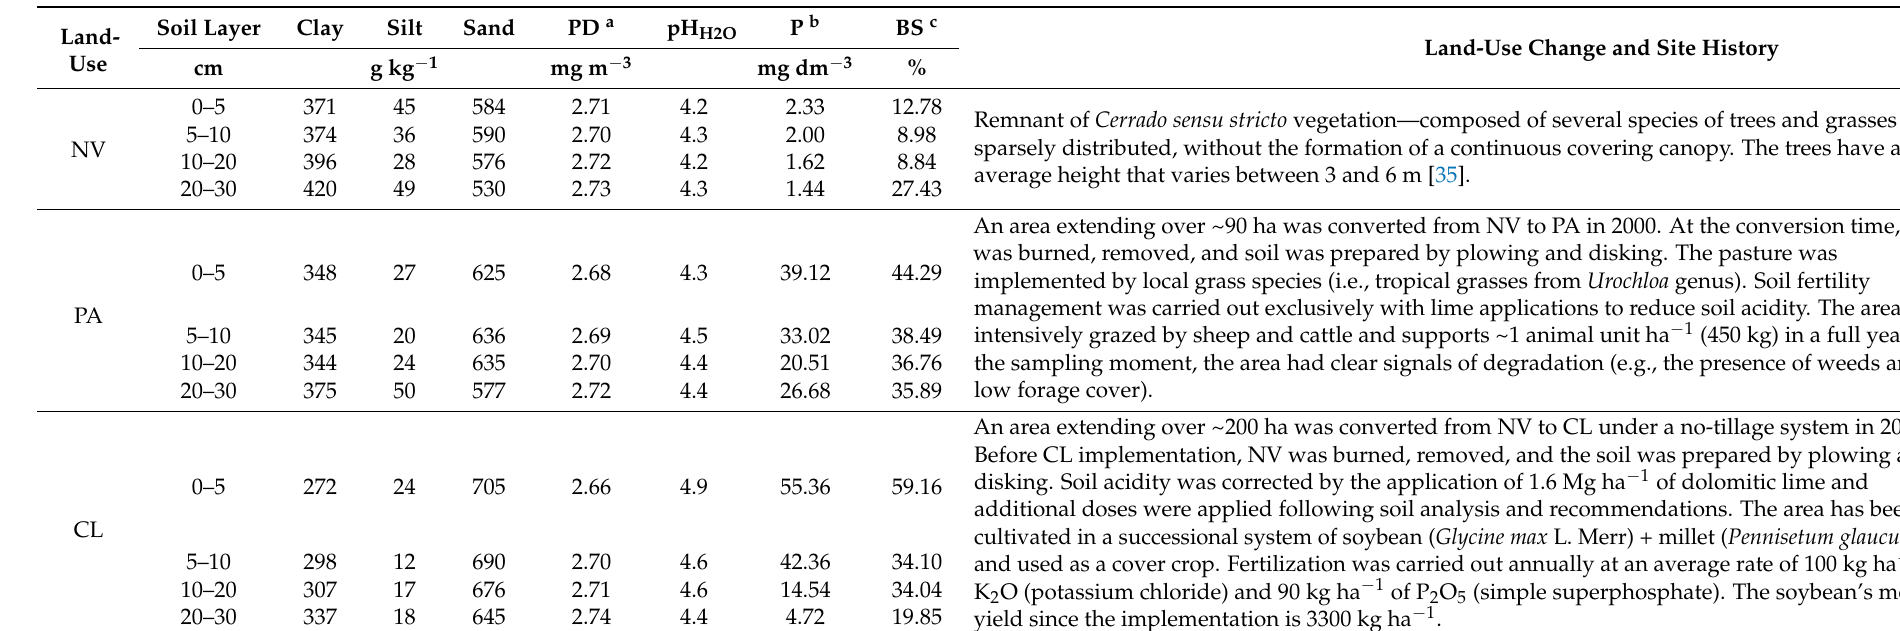
Table 1. Land-use change, management history, and soil characterization for native vegetation (NV), pasture (PA), and cropland (CL) sites [34].